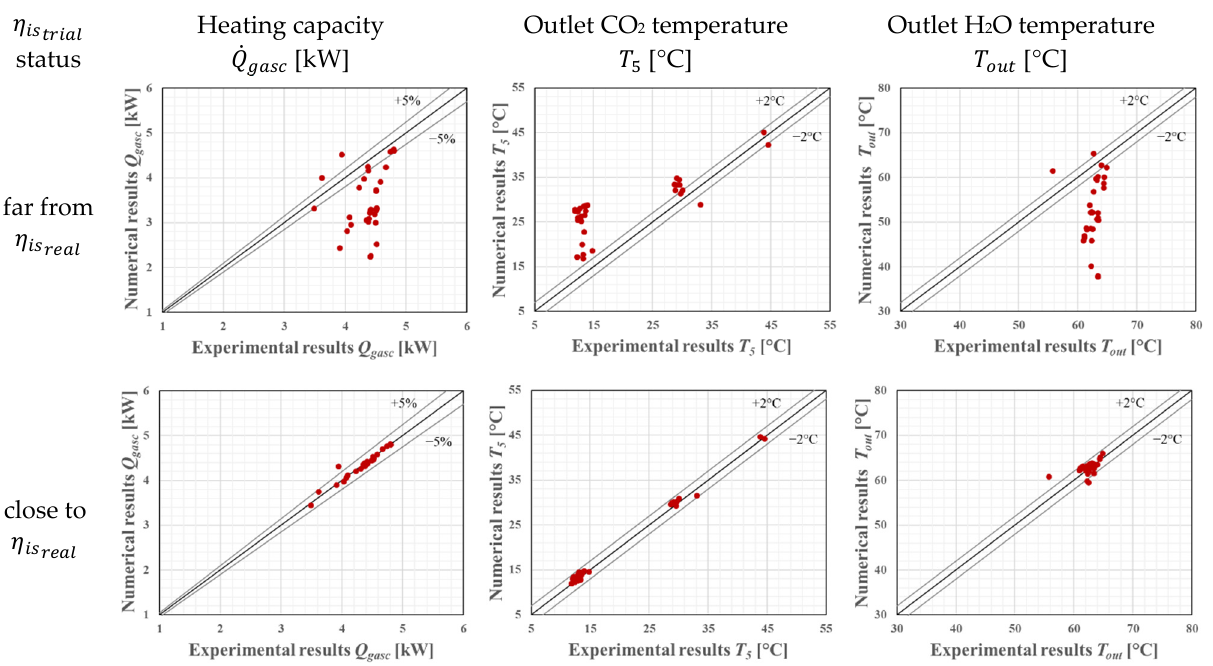
Figure 4. Example of the gas cooler model outputs for different 𝜂 (cid:3036)(cid:3046) trials and working conditions.